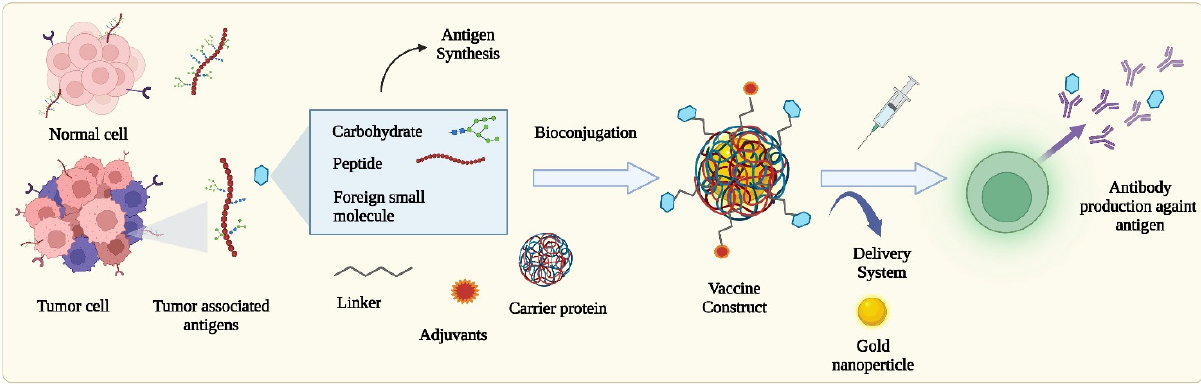
Figure 1. Brief illustration of the antigen-mediated immune response toward cancer cells. Abbrevi- ations: APC, antigen-presenting cell; TCR, T-cell receptor; MHC, major histocompatibility complex.